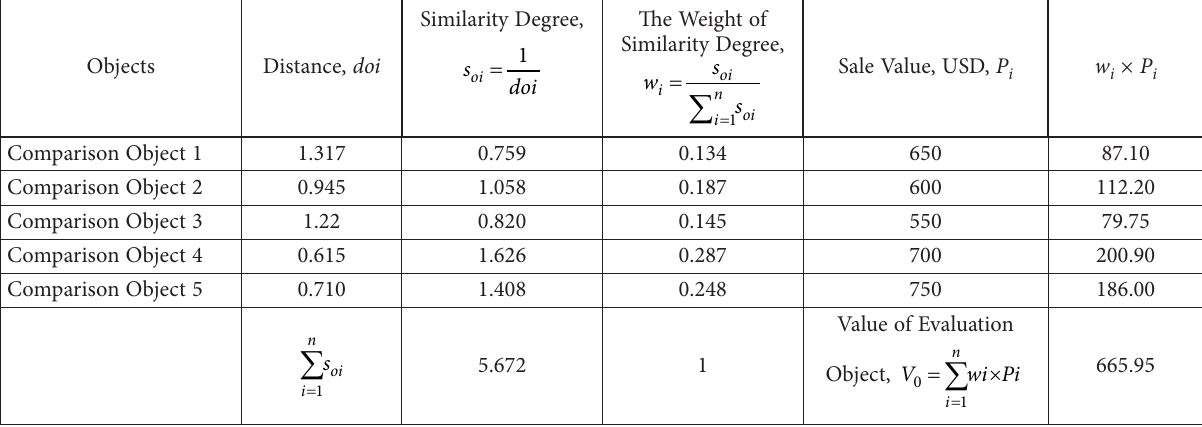
Table 7. Calculation table of value determination of object